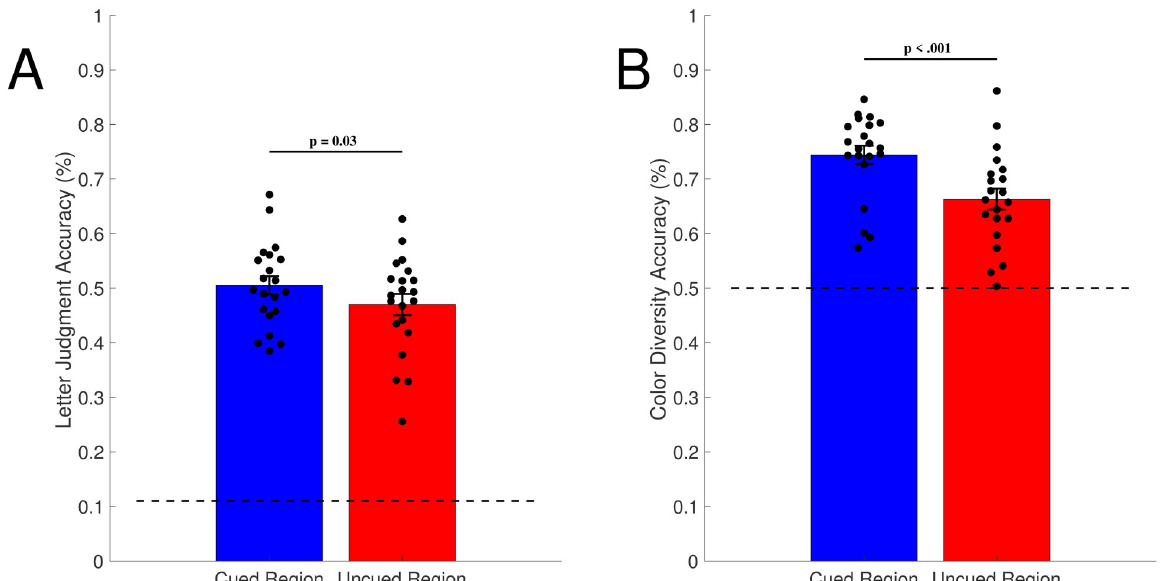
Fig 2. Experiment 1: Average accuracy across subjects for letter recall and color diversity judgments. The mean of all subject averages is shown, with error bars showing SEM across subjects. Dotted lines represent chance-level performance. (A) Letter Recall Task. The average accuracy across subjects for the letter recall task was significantly higher when the color diversity question focused on the cued region of the circle, compared to when this question queried the uncued region of the circle. (B) Color diversity judgments. The average accuracy for color diversity was higher for cued regions of the circle compared to uncued regions of the circle.